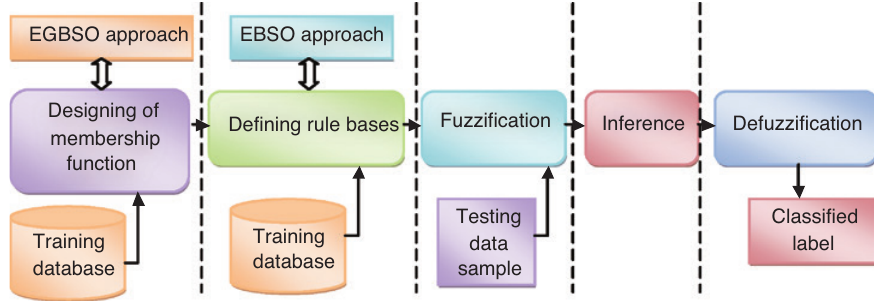
Figure 4: Flow of the Proposed BGFS for